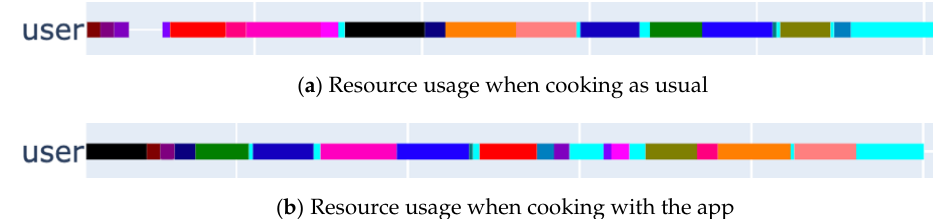
Figure 9. Resource usage (ID = 1).